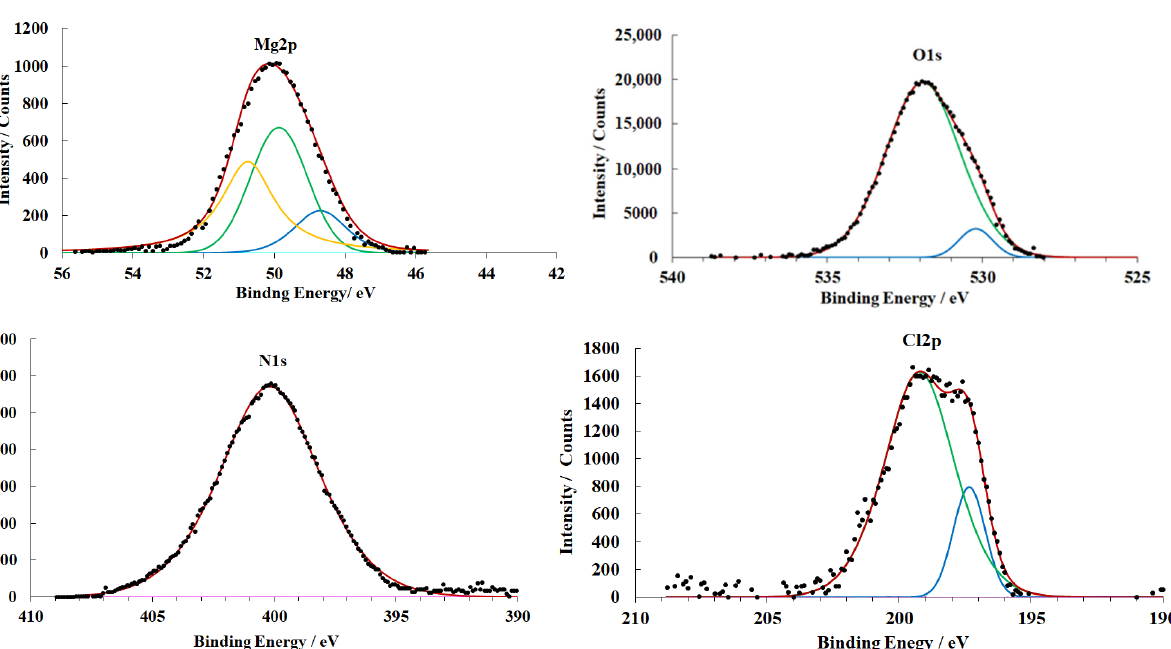
Figure 7. XPS spectra of magnesium alloy samples (preparation mode D ).